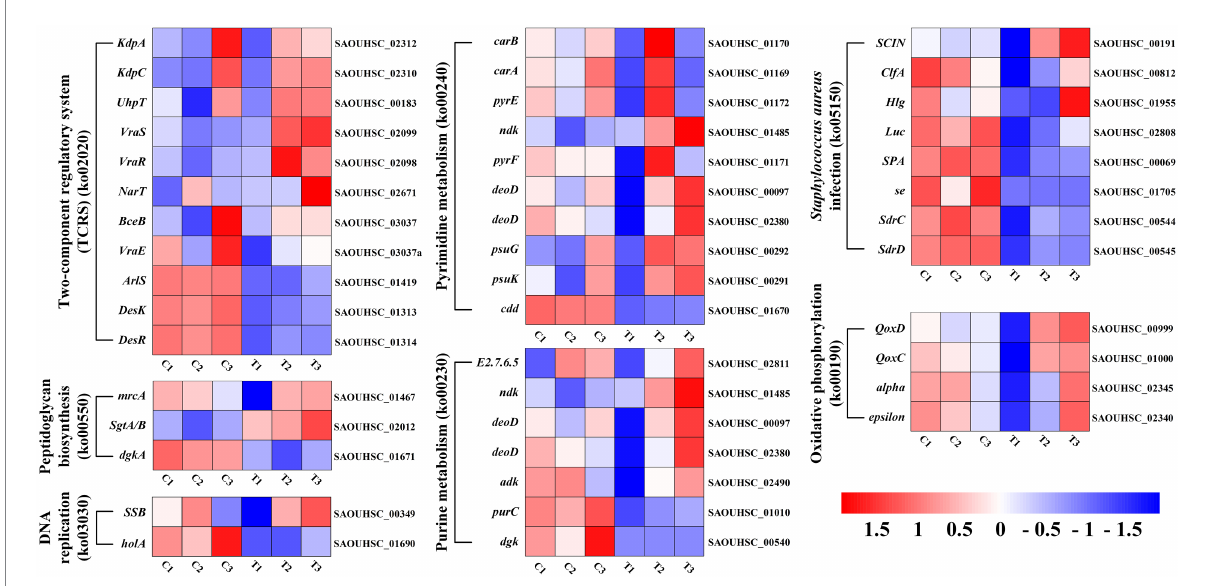
FIGURE 6 Heat map representation of gene expression after FCS treatment relative to two-component regulatory system, peptidoglycan biosynthesis, DNA replication, pyrimidine metabolism, purine metabolism, Staphylococcus aureus infection and oxidative